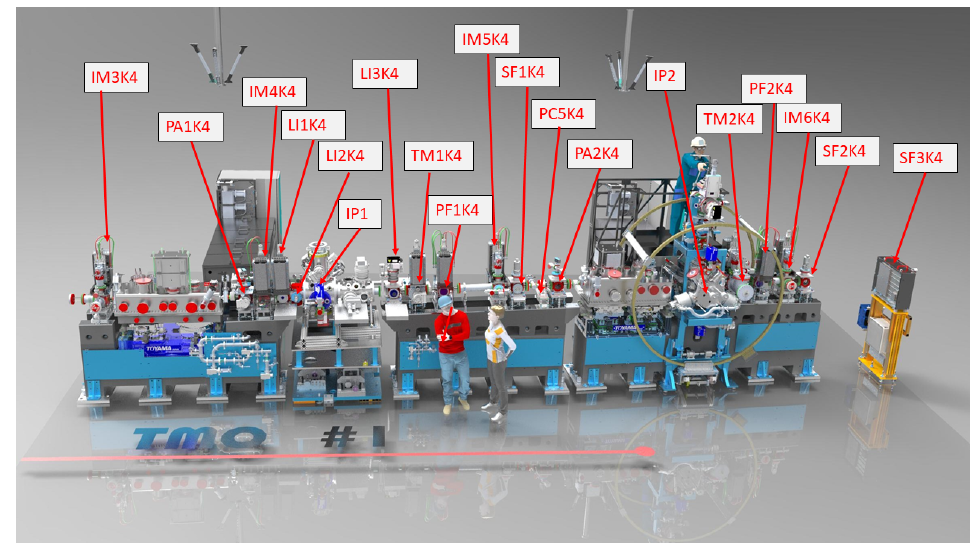
Figure 1. Overview of the TMO instrument layout. Indicated are the beam position monitors IM3K4, IM4K4, IM5K4, IM6K4; differential pumping sections PA1K4 and PA2K4; IP1 optical laser in-coupling LI1K4, LI2K4, and IP1 laser out-coupling LI3K4; the arrival time monitors TM1K4 and TM2K4; wavefront sensors PF1K4 and PF2K4; retractable beam terminators SF1K4 and SF2K4; beamline collimators PC5K4, as well as the interaction points IP1 and IP2, and finally the beam terminator SF3K4. Figure and caption adapted from